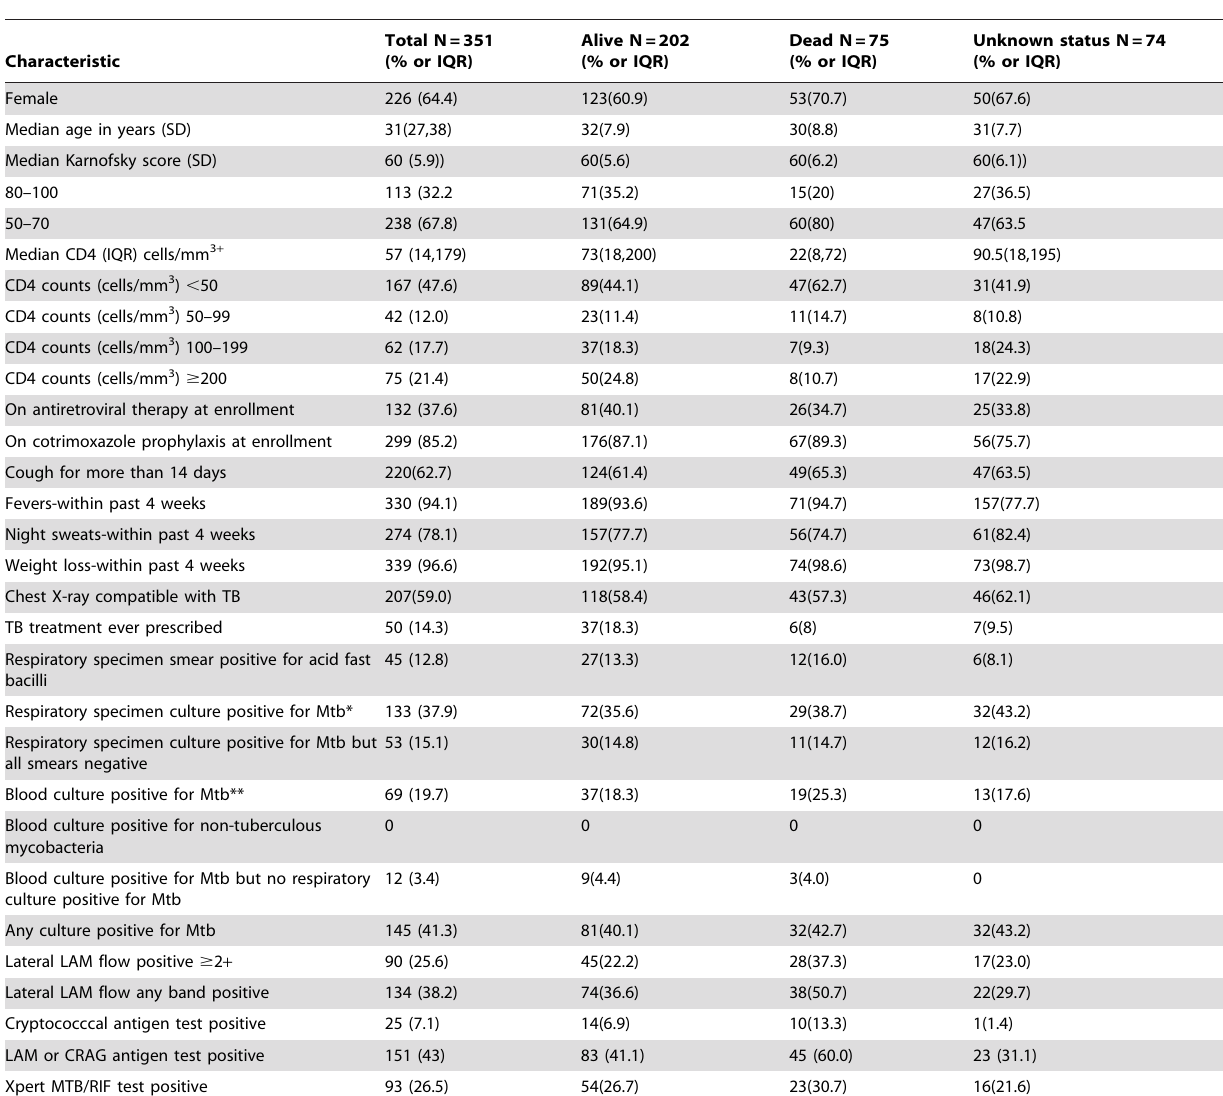
Table 1. Baseline (enrollment) clinical characteristics and laboratory testing results of the hospitalized study population Uganda (N=